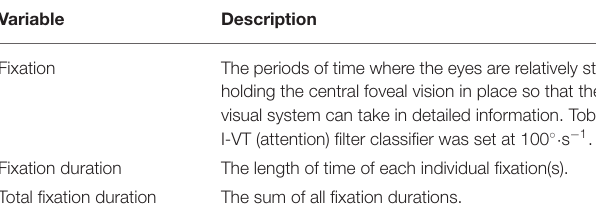
TABLE 1 | Eye movement behavior variables. Variable